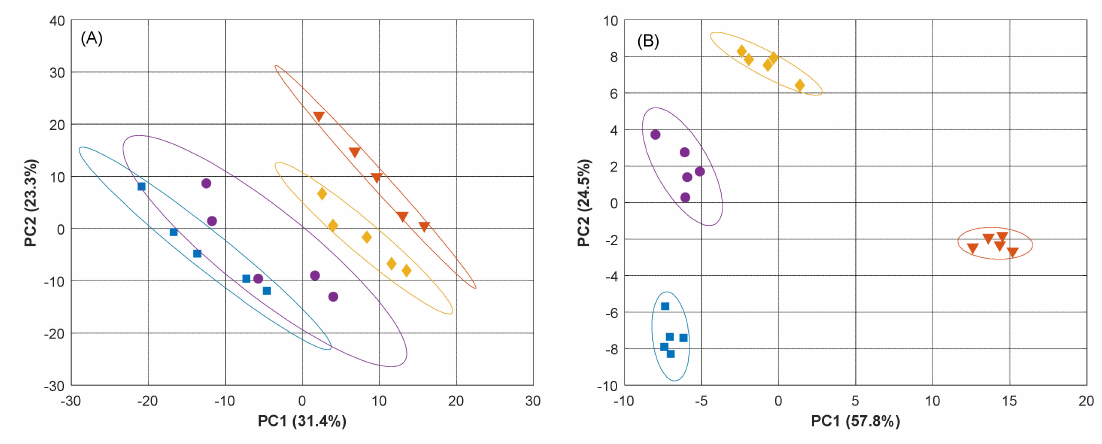
Figure 4. Score plot obtained from the DWT-PCA of five replicas of individual APIs using ( A ) the eight-sensor array or ( B ) the selected four-sensor array. ( (cid:4) ) Bu ff er, ( (cid:72) ) paracetamol, ( • ) ascorbic acid and ( (cid:7) ) uric acid. Ellipses plotted correspond to 95% confidence limits for each of the